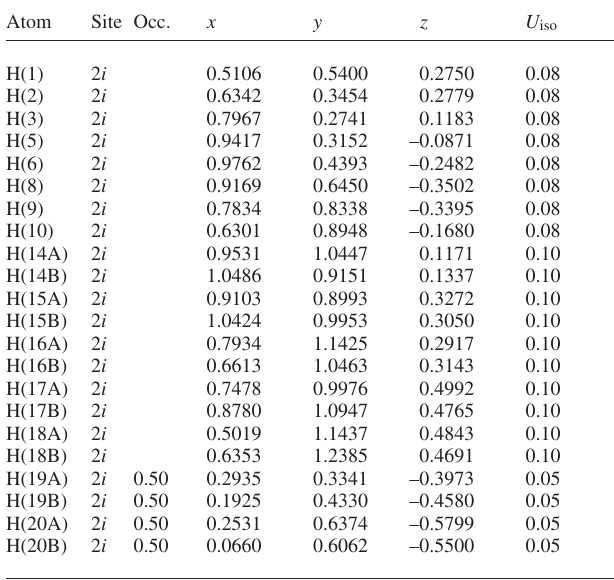
Table 2. Atomic coordinates and displacement parameters (in Å 2 )